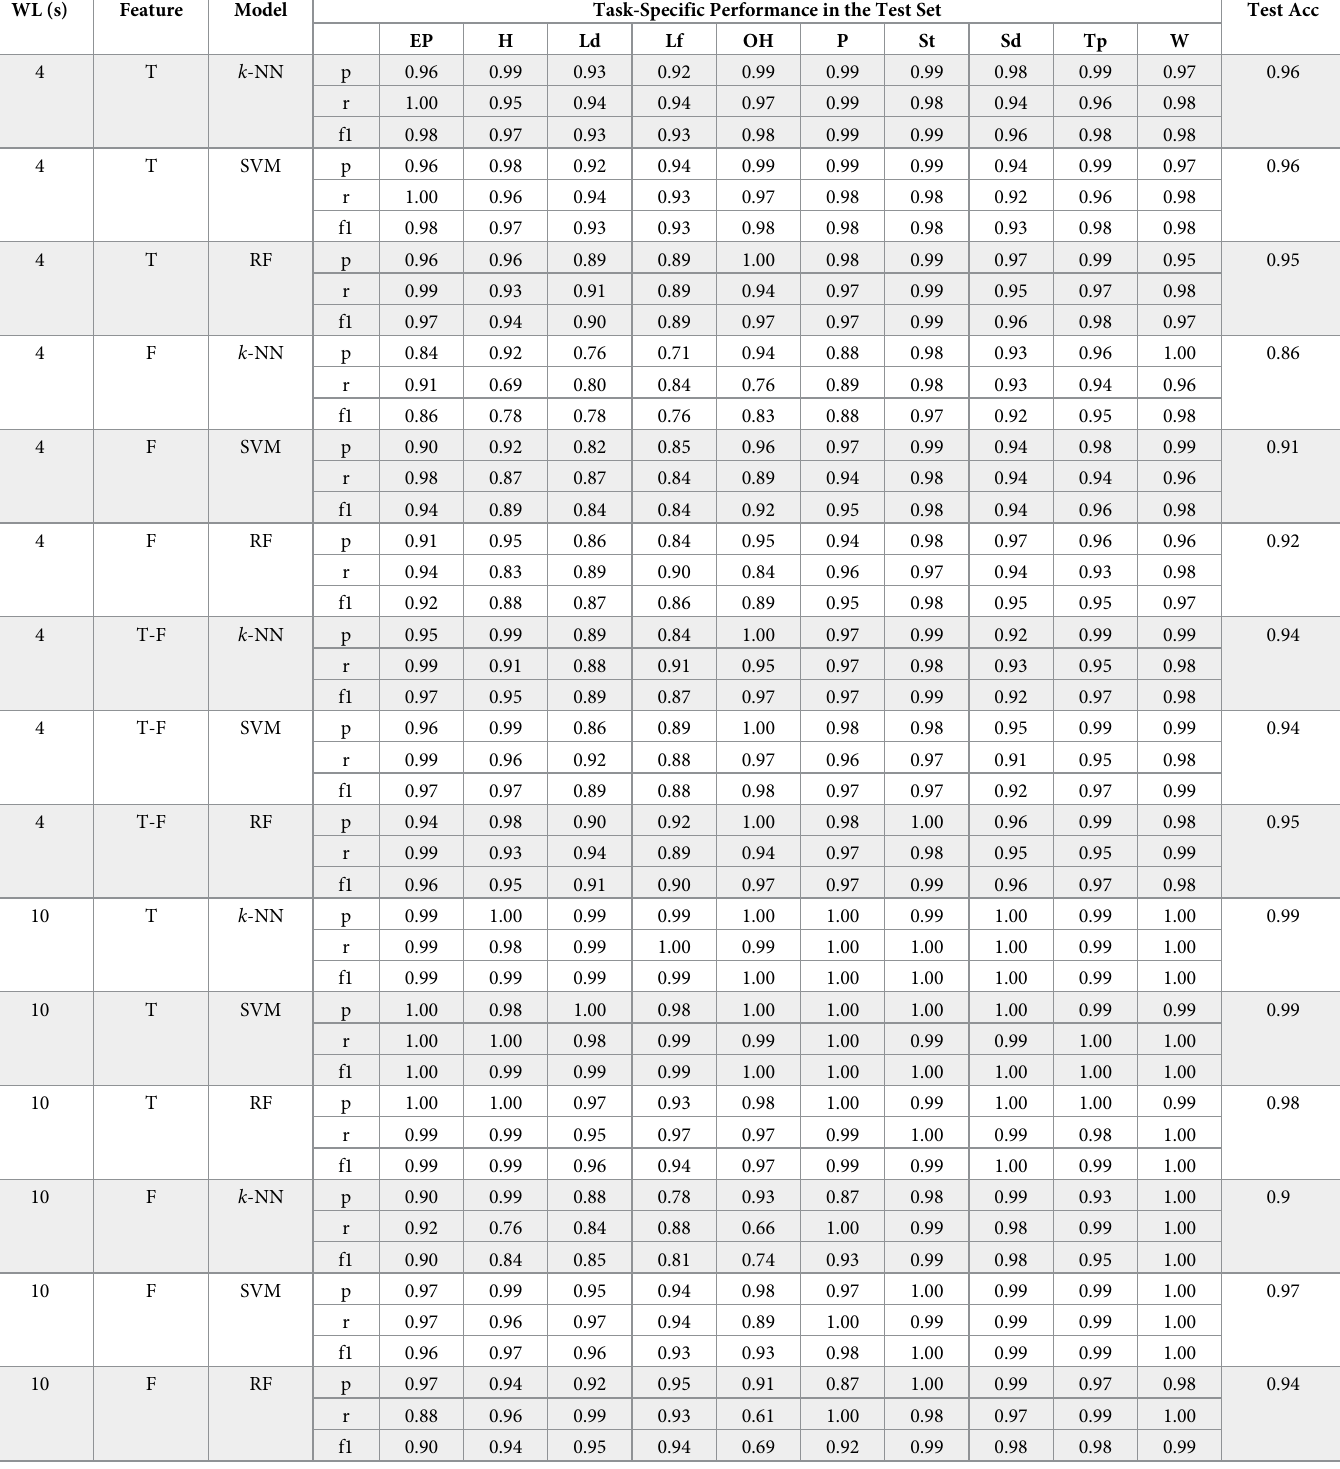
Table 4. Intra-subject classification performance. Abbreviations: WL: window length, T: time, F: frequency EP: electrical panel, H: hoisting, Ld: ladder, Lf: lifting; OH: overhead; P: pushing; St: sitting; Sd: standing; Tp: typing; W: walking. WL